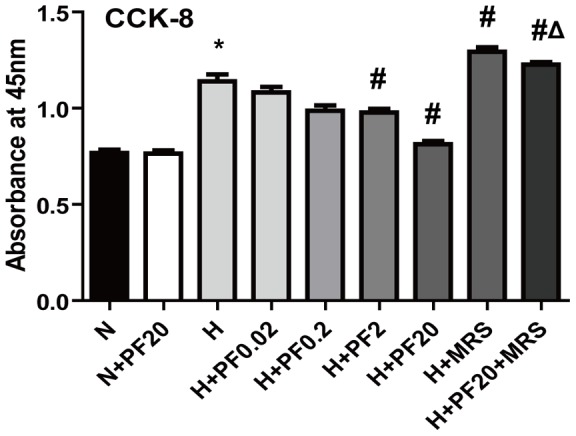
Cell viability was tested with CCK-8. * P<0.05 vs. the N group; # P<0.05 vs. the H group; Δ P<0.05 vs. the H+PF20 group. Mean ± SD, n = 6.